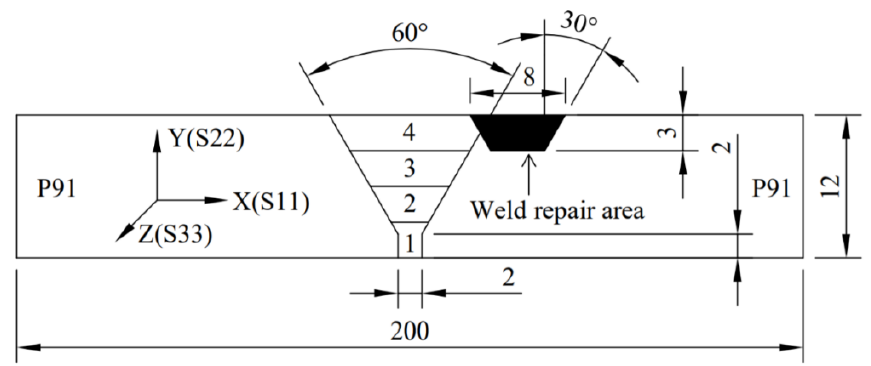
Figure 3. Schematic drawing of the model geometry. (unit: mm).